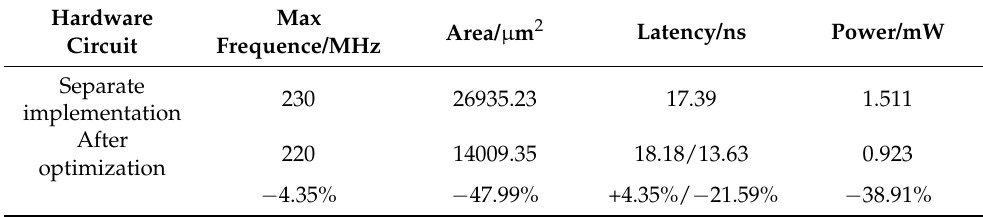
Table 7. Comparison with the hardware circuit without reconfigurable technology.